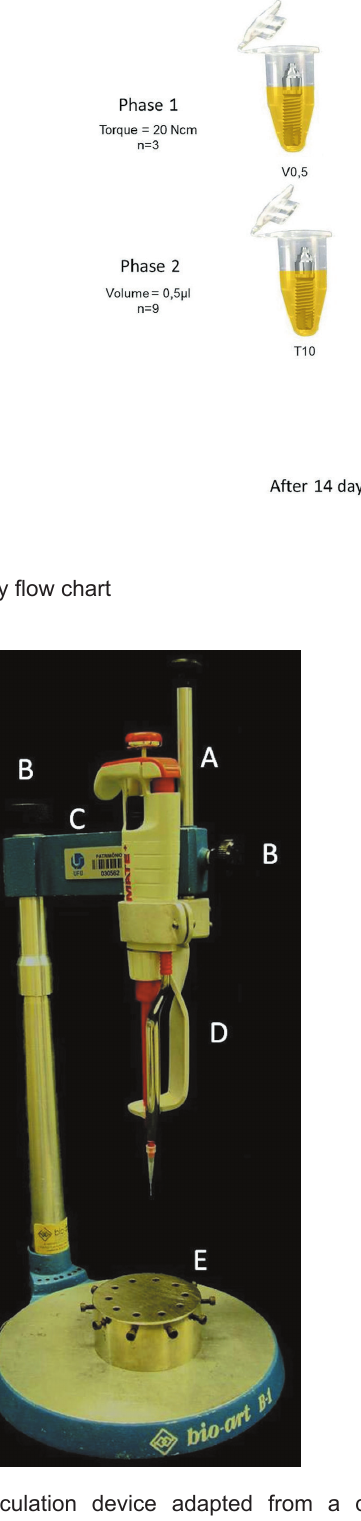
Figure 2- Inoculation device adapted from a dental surveyor. A: vertical rod with pipette holder; B: screw to lock vertical rod; C: cross arm; D: pipette holder;